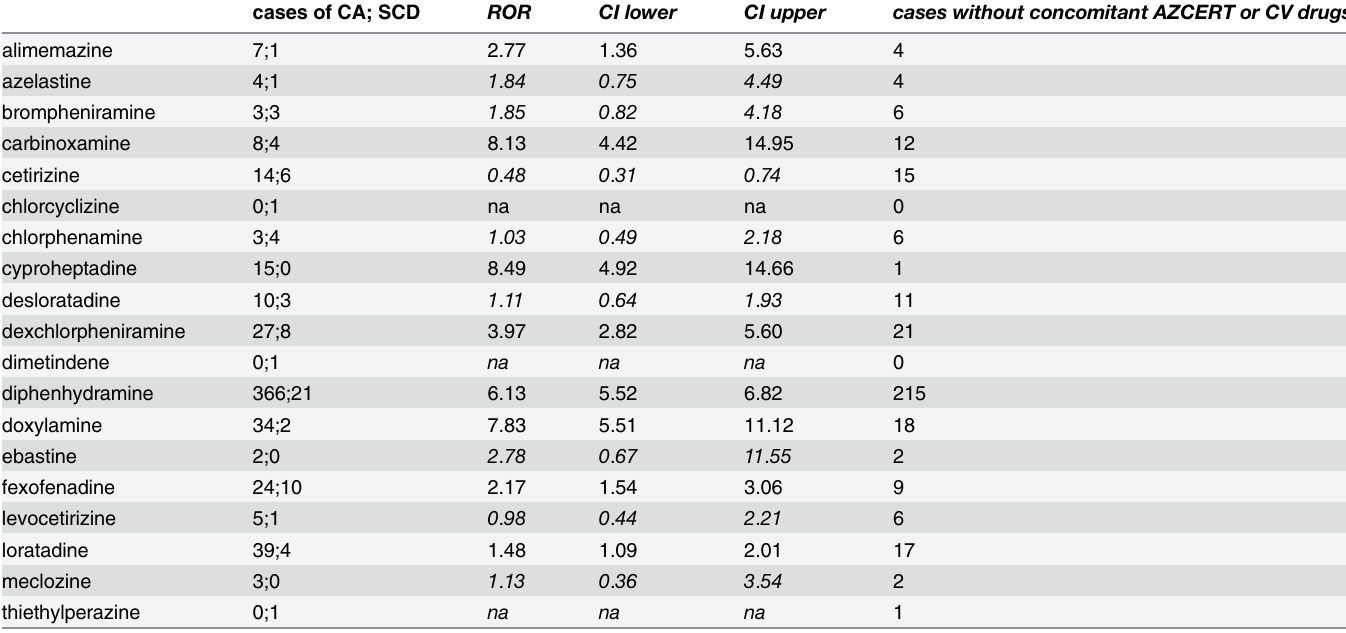
Table 3. Disproportionality analysis for antihistamines with cases of cardiac arrest (CA) or sudden cardiac death (SCD). cases of CA; SCD ROR CI lower CI